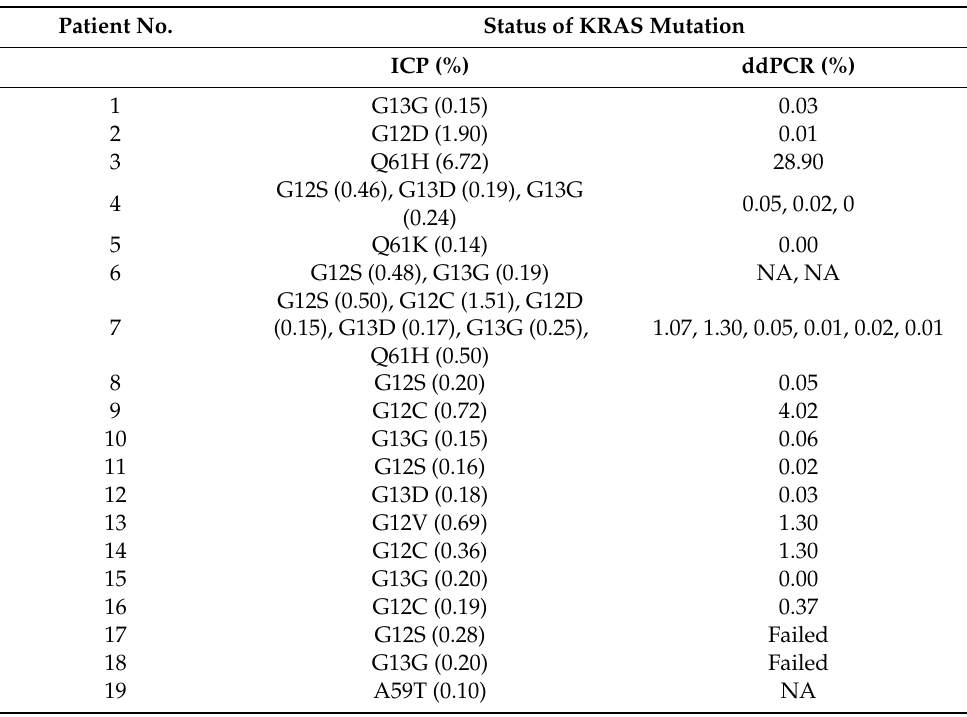
Table 2. Validation of ddPCR in patients with mutated